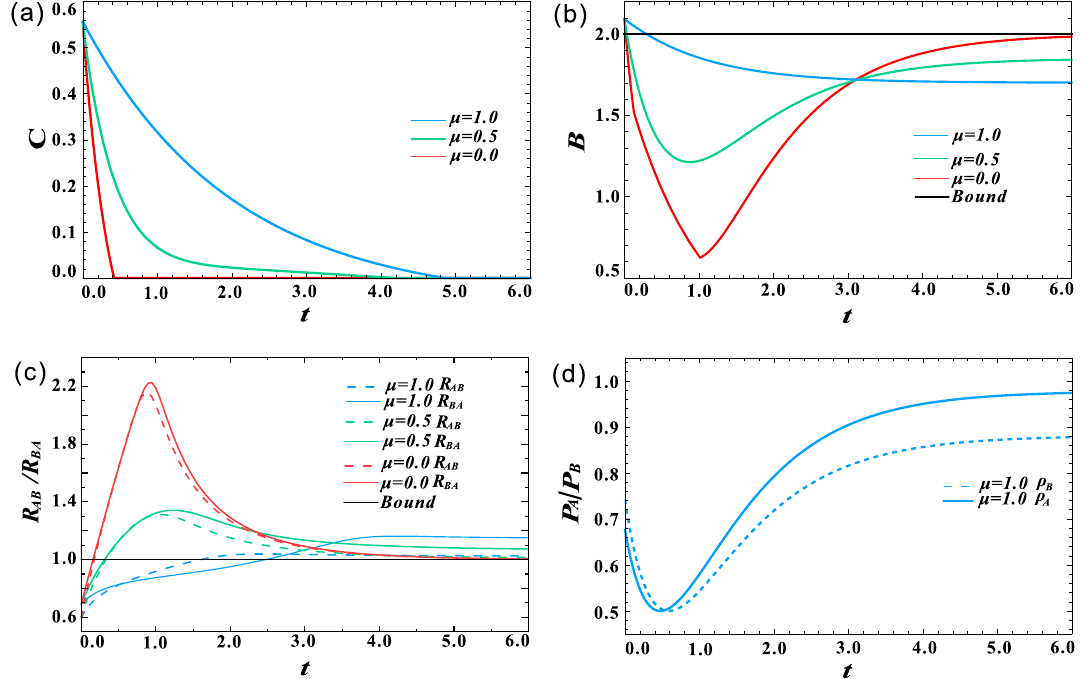
Figure 2. (Color online) Effect of channel correlation strength µ on the decay of nonlocal quantum correlations n 0 . ( a ) Concurrence C as a function of decoherence time t for different µ . ( b ) Bell parameters B when m = = as a function of decoherence time t for different µ . ( c ) Critical radii R AB and R BA as a function of decoherence time t for different µ . ( d ) Purities P A and P B as a function of decoherence time t when µ